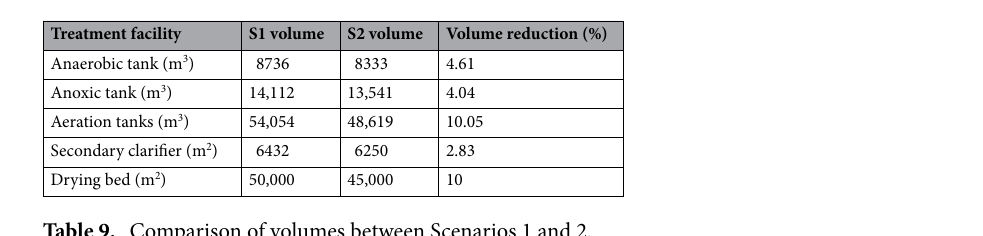
Table 9. Comparison of volumes between Scenarios 1 and